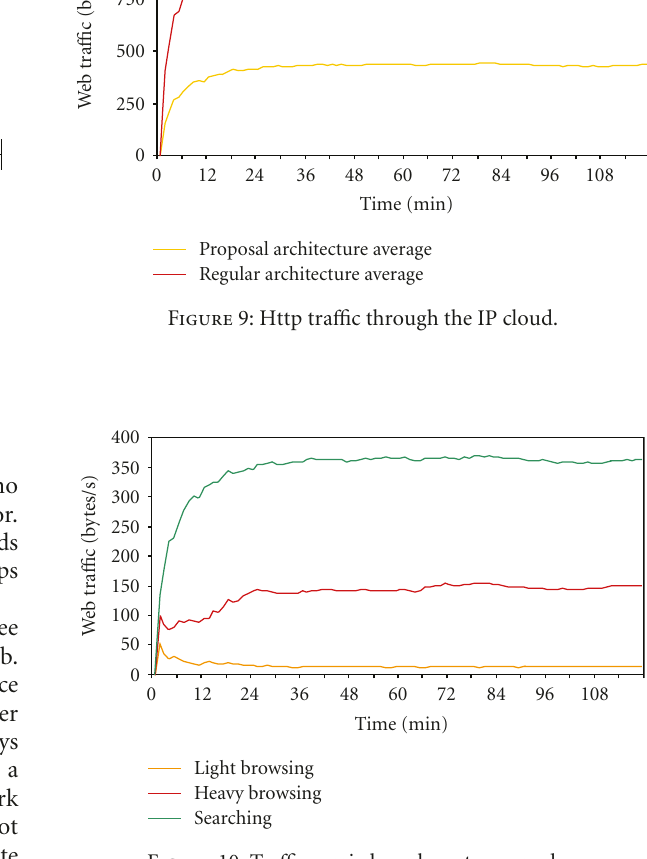
Figure 10: Tra ffi c carried our by gateway